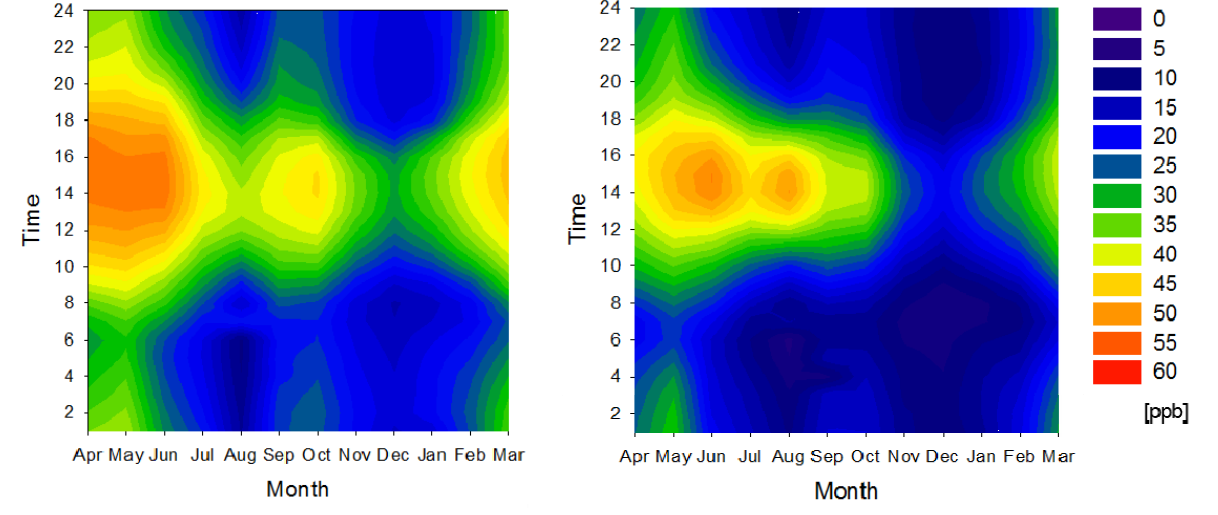
Figure 6. O x concentration contour maps for clusters 2 ( A ) and 4 ( B ) in